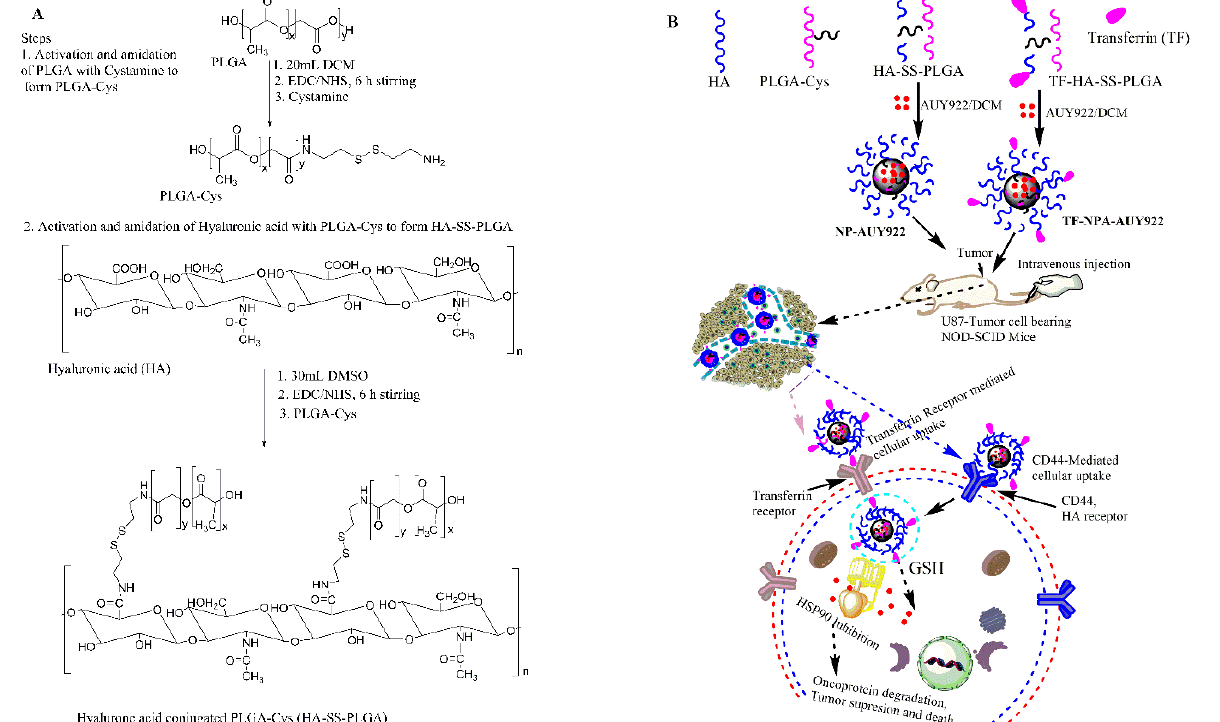
Scheme 1. ( A ) Scheme of HA-SS-PLGA synthesis and ( B ) transferrin and CD44 receptor-mediated cellular uptake of AUY922-loaded